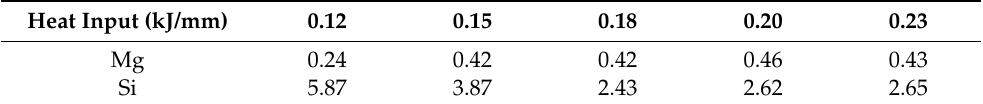
Figure 3. EDS analyses of ( a ) substrate, ( b ) filler wire and the three various beads: heat input of ( c ) 0.12 kJ/mm; ( d ) 0.18 kJ/mm; ( e ) 0.23 kJ/mm. Table 3. Concentration of Mg and Si in different beads (wt%).